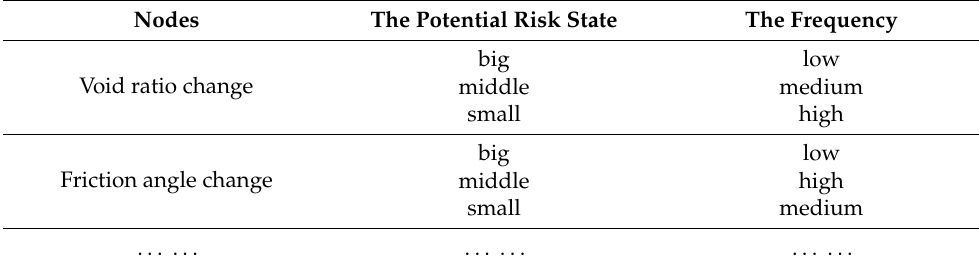
Table 2. Cont. Nodes The Potential Risk State The Frequency big low Void ratio change middle medium small high big low Friction angle change middle high small medium